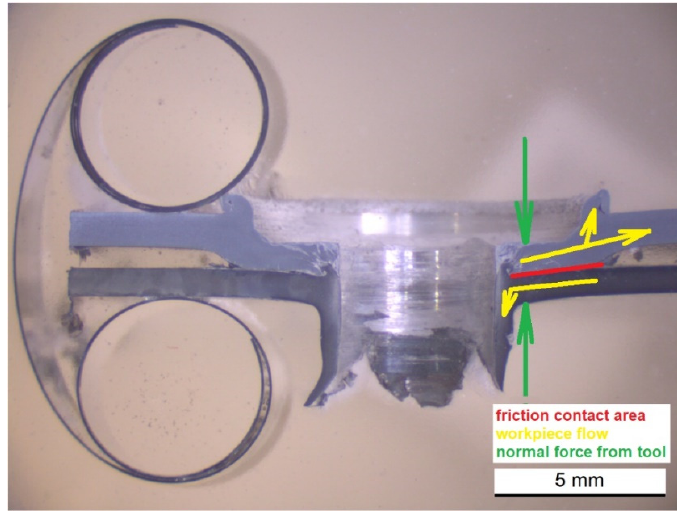
Figure 17. Scheme of friction joint formation.